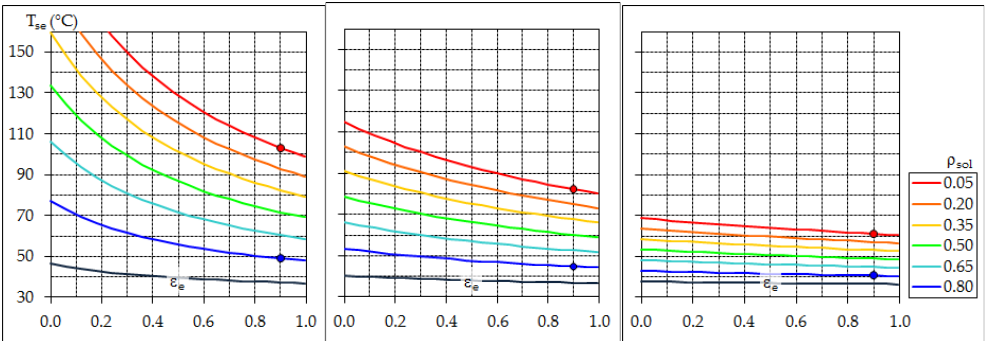
Figure 1. Surface temperature T se for reference ambient conditions and (from left to right) low (v wind < 2 m/s, h ce = 5 W/(m 2 K)), intermediate (2 m/s < v wind < 6 m/s, h ce = 12 W/(m 2 K)), and high (6 m/s < v wind < 10 m/s, h ce = 30 W/(m 2 K)) wind speed; blue and red dots are for the reference white and black surfaces, respectively.